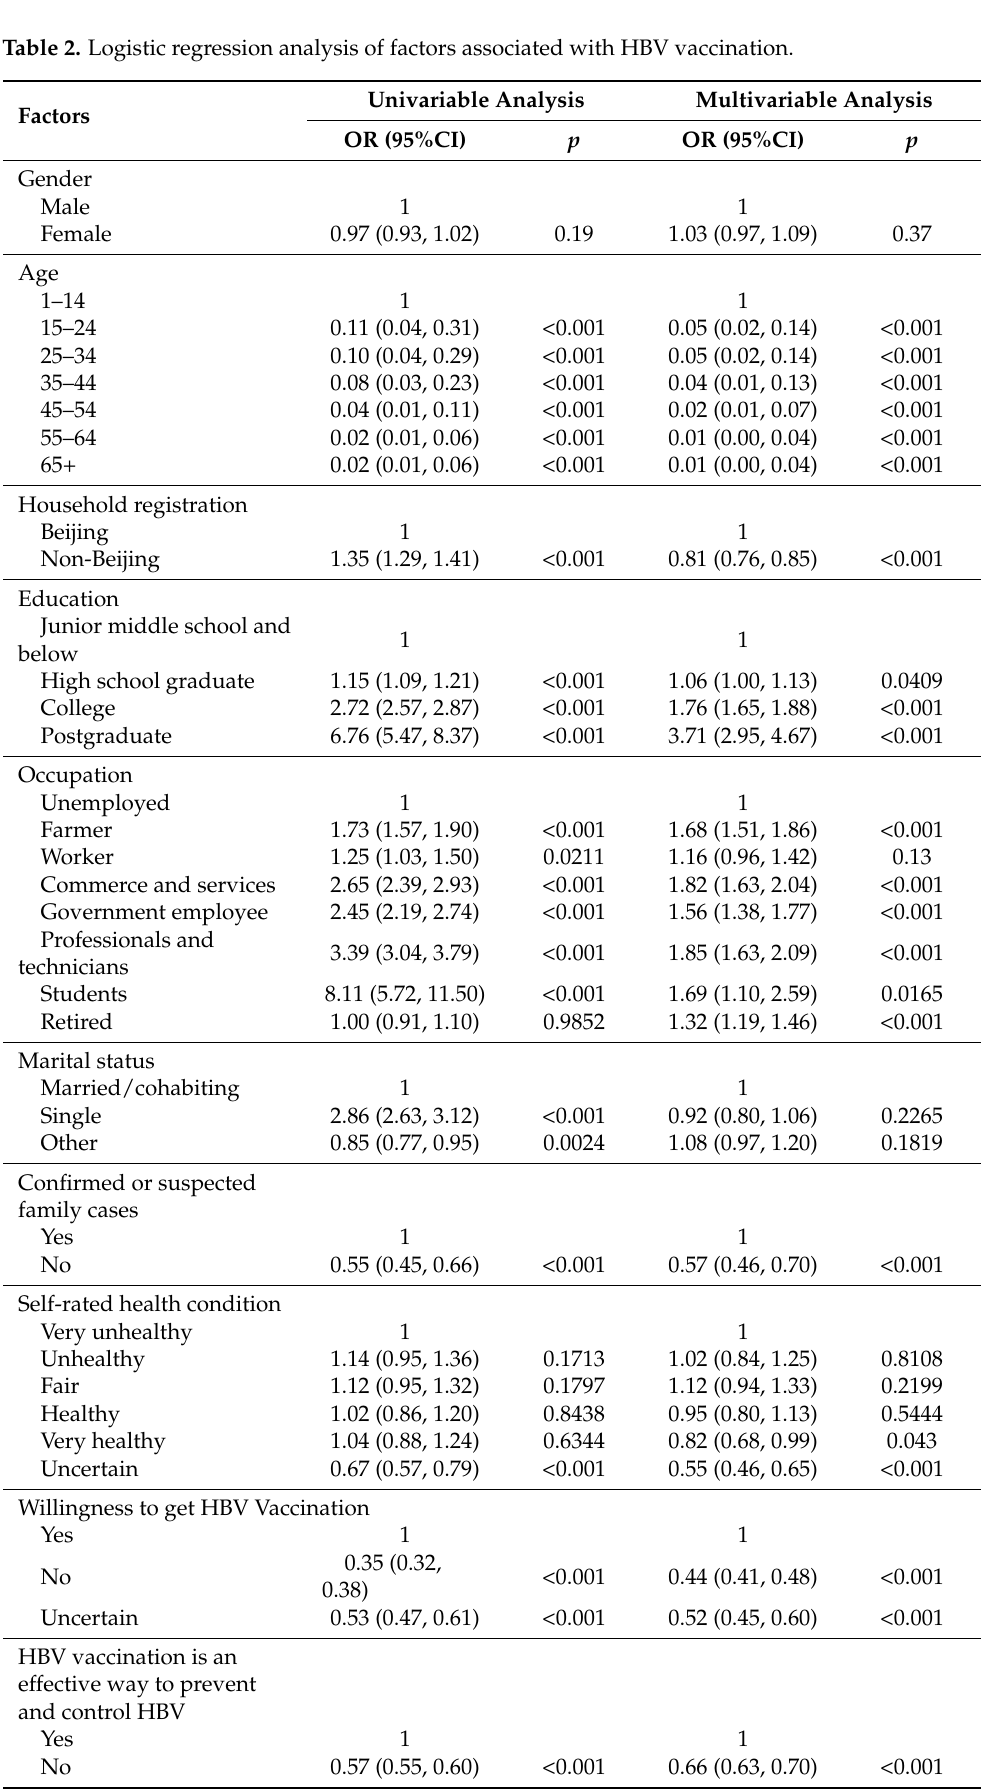
Table 2. Logistic regression analysis of factors associated with HBV